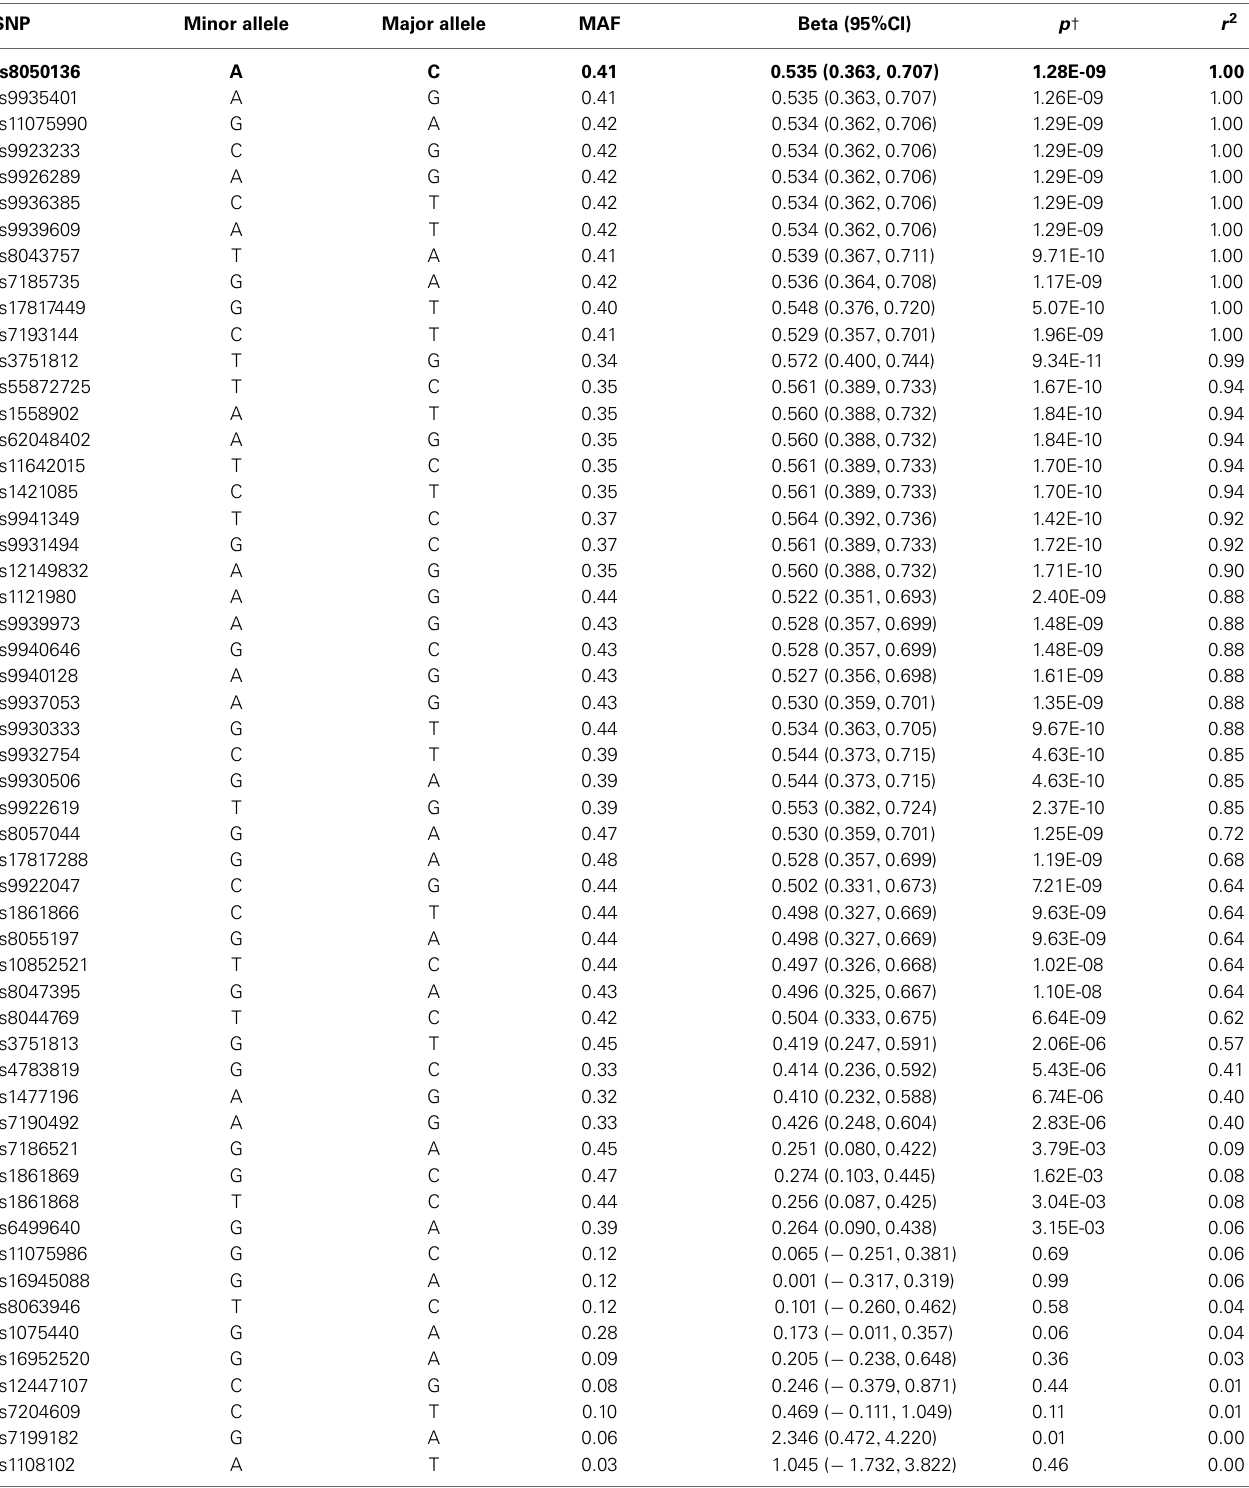
Table 2 | Association between FTO variants and average